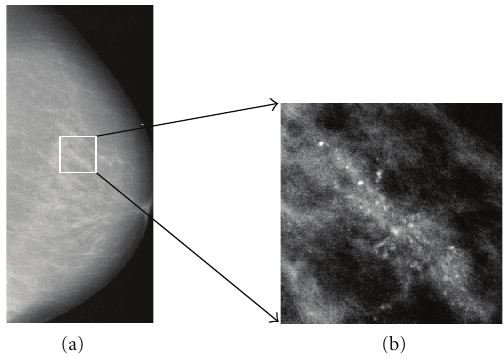
Figure 1: A mammogram image in CC view (a) and clustered microcalcifications in magnified view